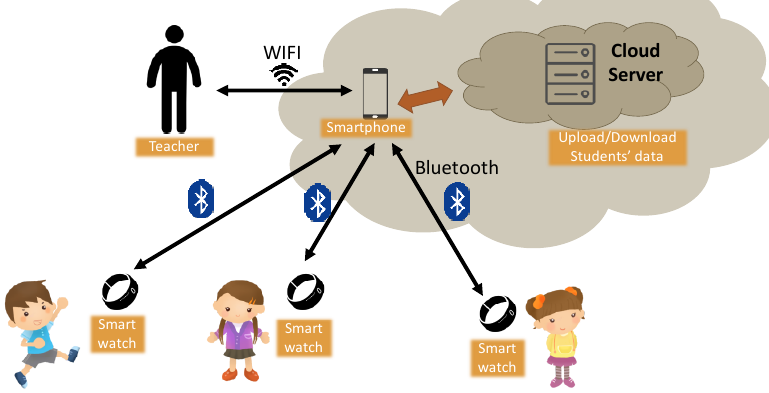
Figure 1. System Figure 1. System architecture.